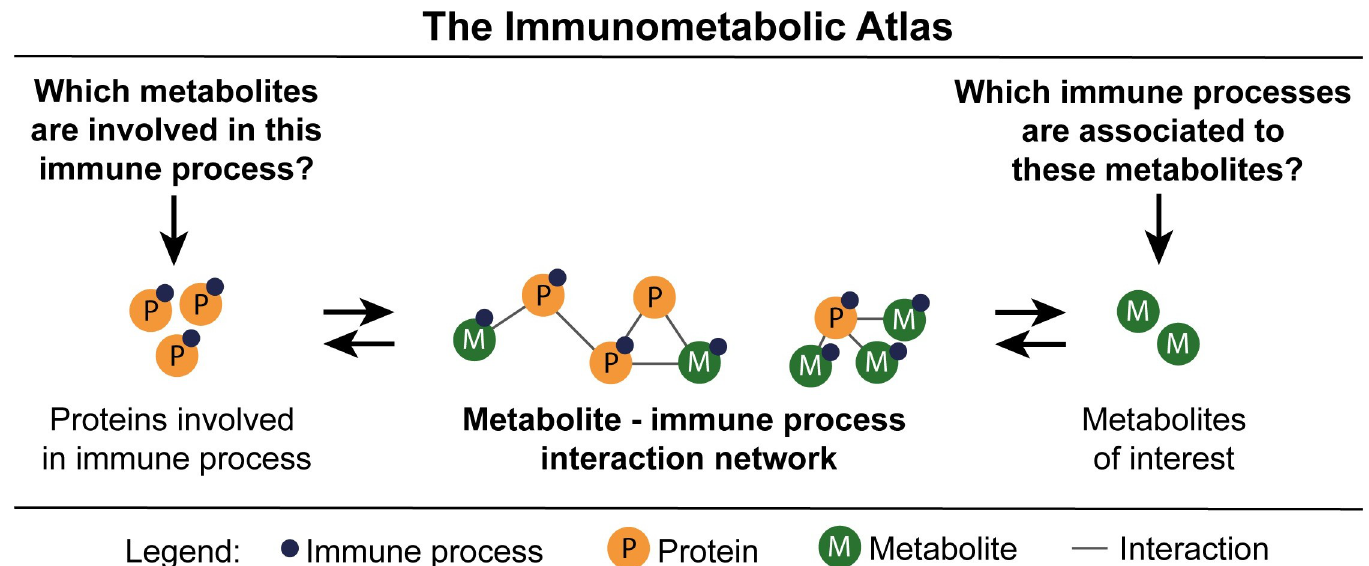
Fig 1. A conceptual overview of the Immunometabolic Atlas (IMA). The IMA provides associations between metabolites and immune processes of interest through the generation and evaluation of a protein-metabolite interaction